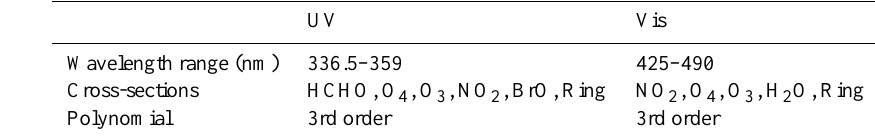
Table 1. DOAS settings used for the UV and Vis. For more details, see Pinardi et al. (2013) for the UV and Hendrick et al. (2014) for the Vis.